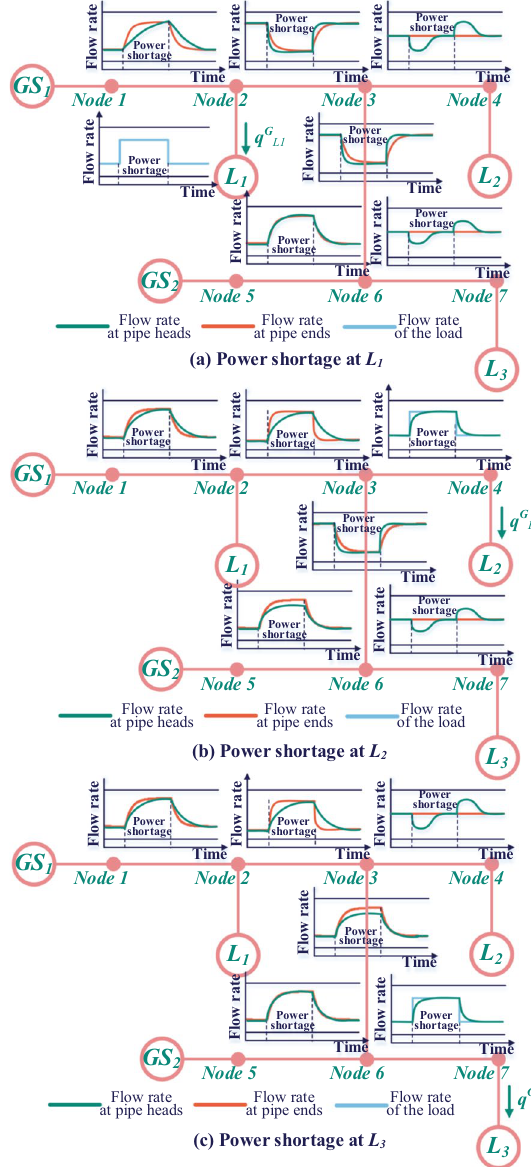
Fig. 3 Flow rate variations in gas network pipelines with power shortages at L 1 , L 2 and L